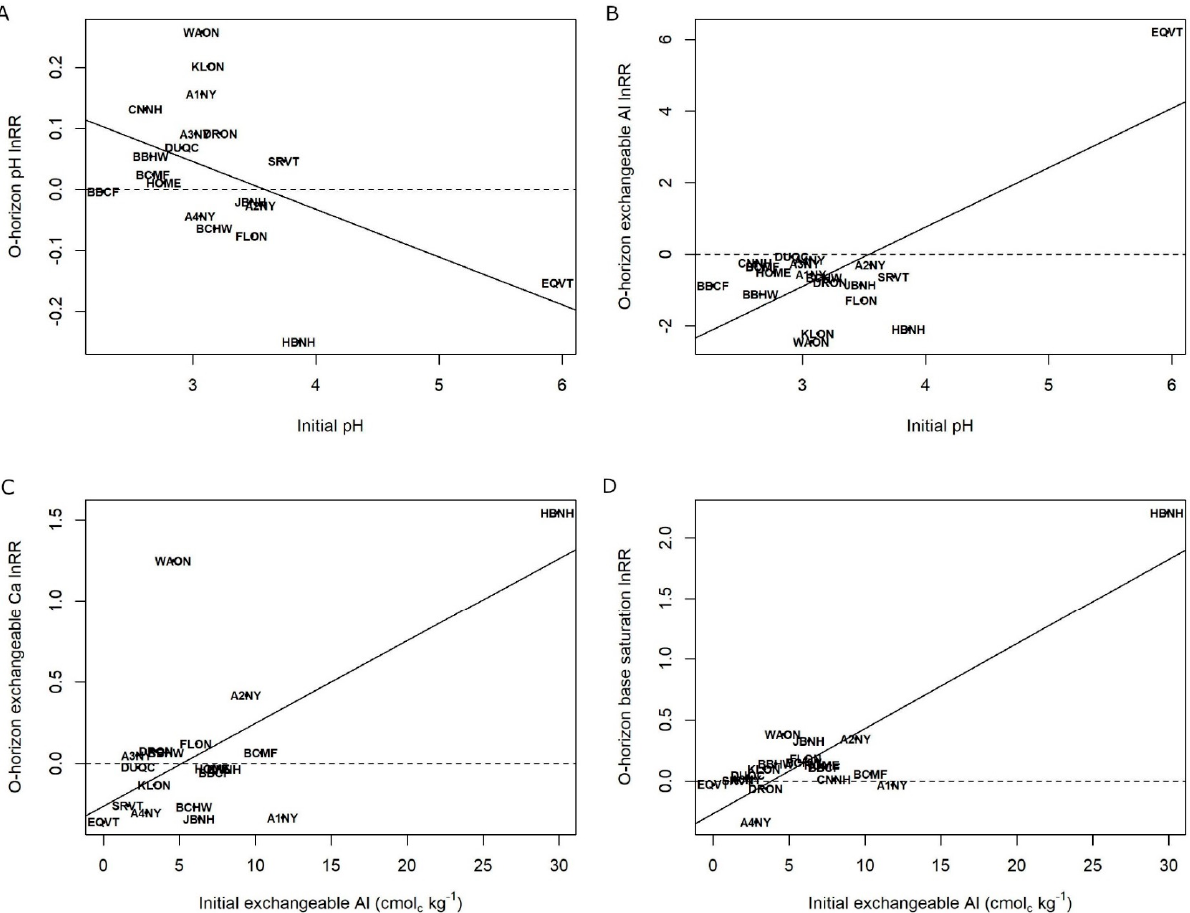
Figure 8. Correlation of O horizon ( A ) initial pH and pH lnRR, ( B ) initial pH and exAl lnRR, ( C ) initial exAl and exCa lnRR and ( D ) initial exAl and BS lnRR for 19 soil resampling sites in Eastern Canada and the Northeastern United States.